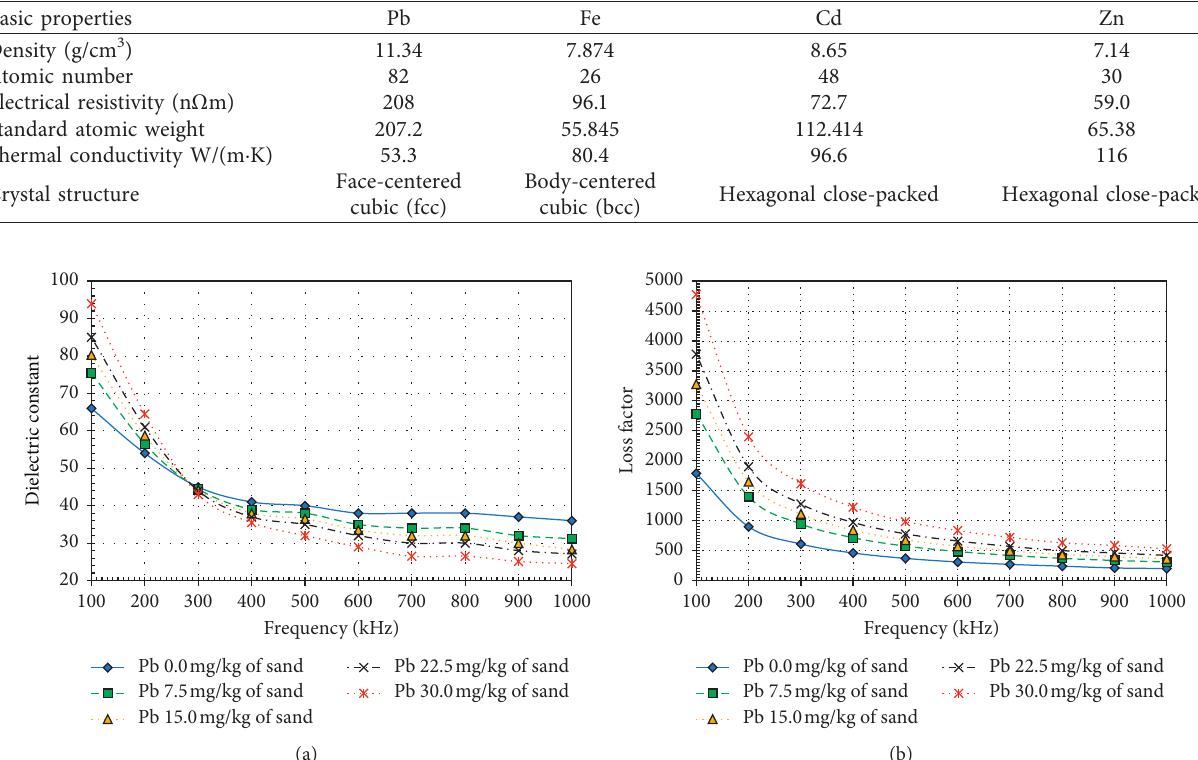
Figure 3: Complex permittivity of sand contaminated with Pb. (a) Dielectric constant versus frequency. (b) Loss factor versus frequency.